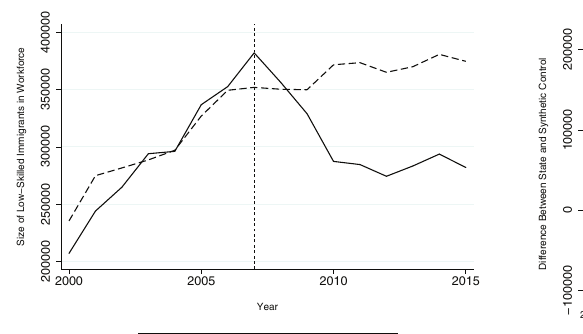
LAWA and size of low-skilled immigrant